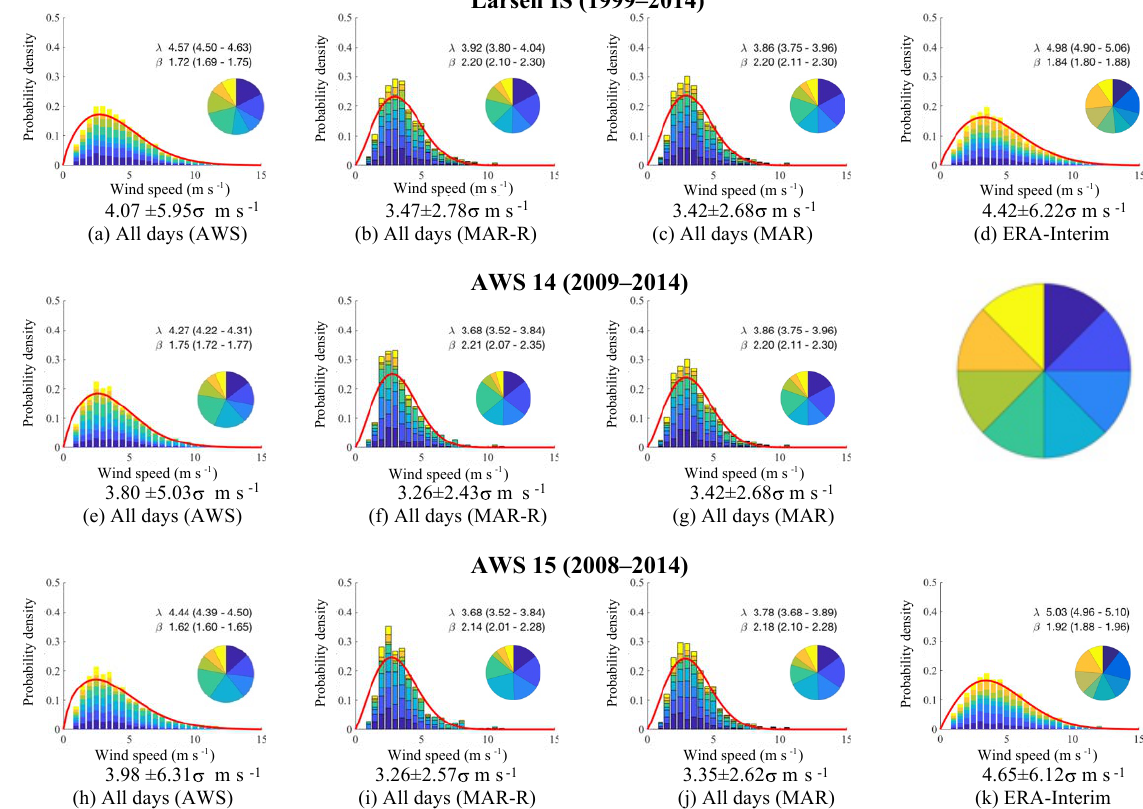
Figure 8. Probability distribution ( y axis) of summer (DJF) wind speeds ( x axis) and direction proportions inset. Wind directions corre- sponding to colours in 45 ◦ increments shown right of (g) . Curve shows Weibull curve shape ( β ) and scale ( λ , ms − 1 ). Datasets for AWS (col 1), MAR-R (col 2), MAR from 1999–2014 period (col 3), and ERA-Interim for the AWS-restricted period (col 4). Shown for station